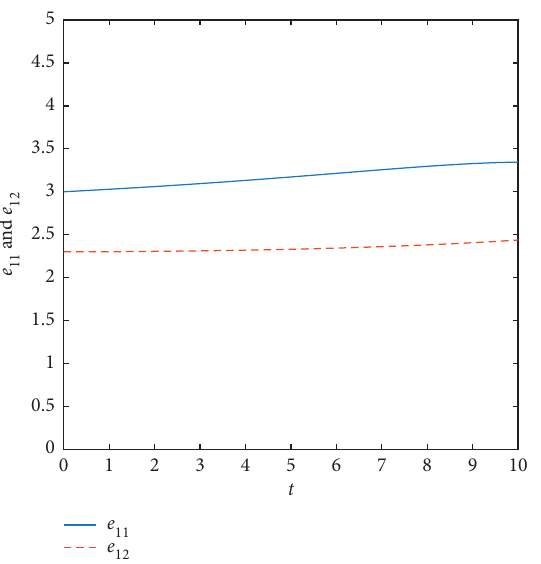
Figure 12: The pollution abatement investment trajectory of the upstream region under cooperation.